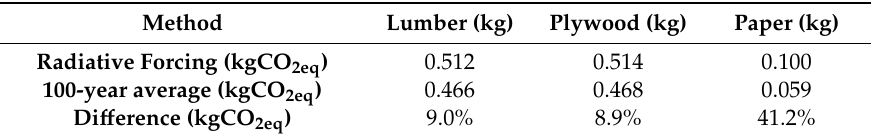
Table 4. Long-term climate benefit (expressed per unit of product output in year 0) by primary product: a comparison using radiative forcing method and 100-year average